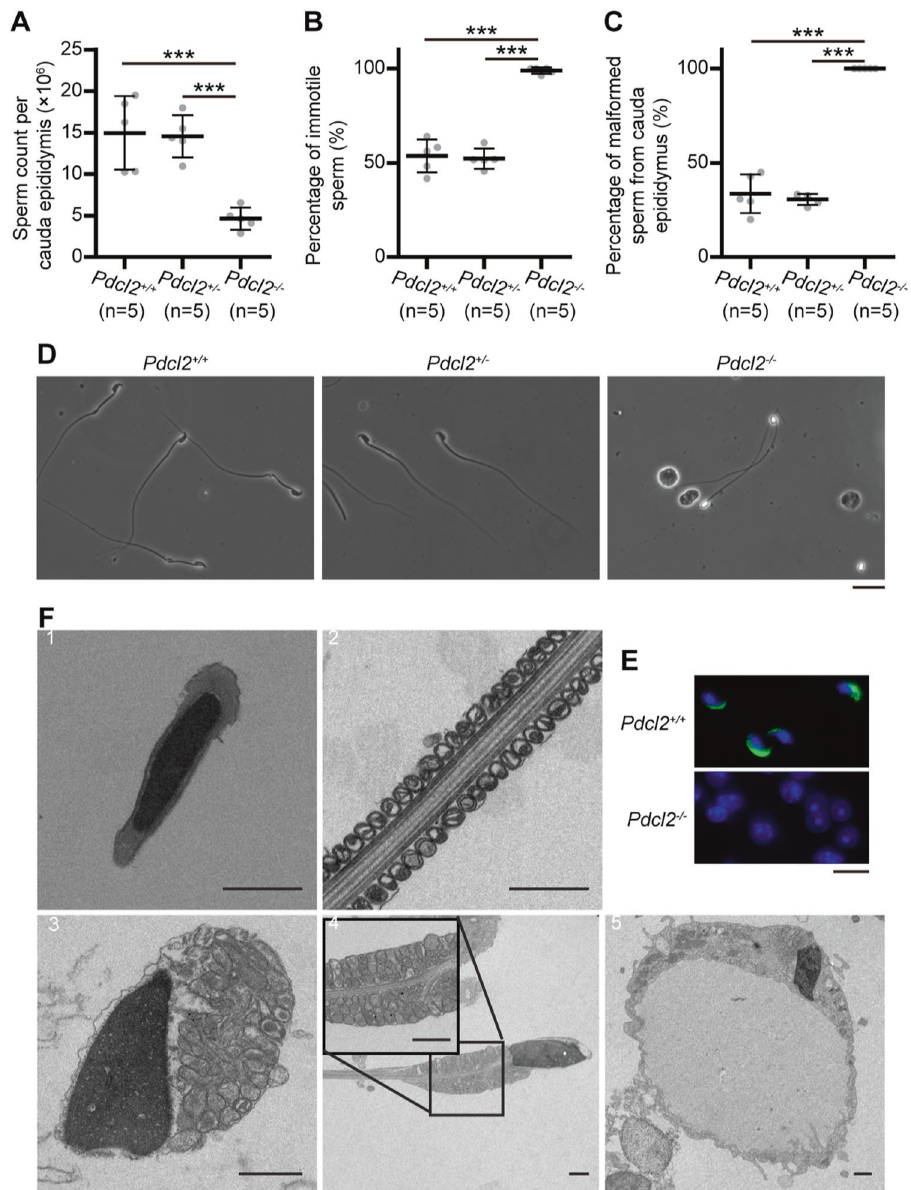
Fig. 4 Malformed sperm of Pdcl2 − / − mice. A Sperm number per cauda epididymis of 11-week-old male mice. B Percentage of immotile sperm. C Percentage of malformed sperm. Data of this fi gure were represented as mean ± standard deviation. *, p < 0.05; **, p < 0.01; ***, p < 0.001. n, mouse number. D Light microscopic analysis of sperm extracted from cauda epididymis. Bar, 20 µm. E Immuno fl uorescent analysis of the acrosomal structure of sperm extracted from cauda epididymis. SP56 is a constituent of the acrosomal matrix and was labeled in green. Hoechst 33342 labeled cell nuclear was in blue. Bar, 10 µm. F Observation of ultrastructure of sperm with transmission electron microscope. 1, sperm head of wild-type mice. 2, sperm midpiece of wild-type mice. 3 – 5, sperm of Pdcl − / − mice, with improper condensed nucleus and abnormal mitochondrial distribution. 3, head and tail were twined together. 4, the axoneme was branched. 5, large vacuole. Bar, 1 µm. Alexa Fluor 488-conjugated donkey anti-mouse IgG (1: 500, Molecular Probes, A-21202), Alexa Fluor 555-conjugated donkey anti-rabbit IgG (1: 500, Molecular Probes, A-31572). Sperm quantity and motility analysis Sperm from cauda epididymis was analyzed as previously described [37]. Immuno fl uorescent analysis of testes sections Experiment procedures were as previously described [37] with modi fi ca- Transmission electron microscope analysis of sperm tions. Testes were fi xed in PFA. Tissue-paraf fi n blocks were sectioned into Sperm samples were collected as previously described [37]. Samples were 7 μ m slices. centrifuged and washed with PBS for three times at 500 × g for 2 min each Usages of primary antibodies were as follows: time. Sperm samples were fi xed by adding 1 mL glutaric dialdehyde and rabbit anti-PDCL2 antibody (1: 5000), stored at 4 °C overnight. Samples were stained with uranyl acetate and Usages of secondary antibodies were as follows: